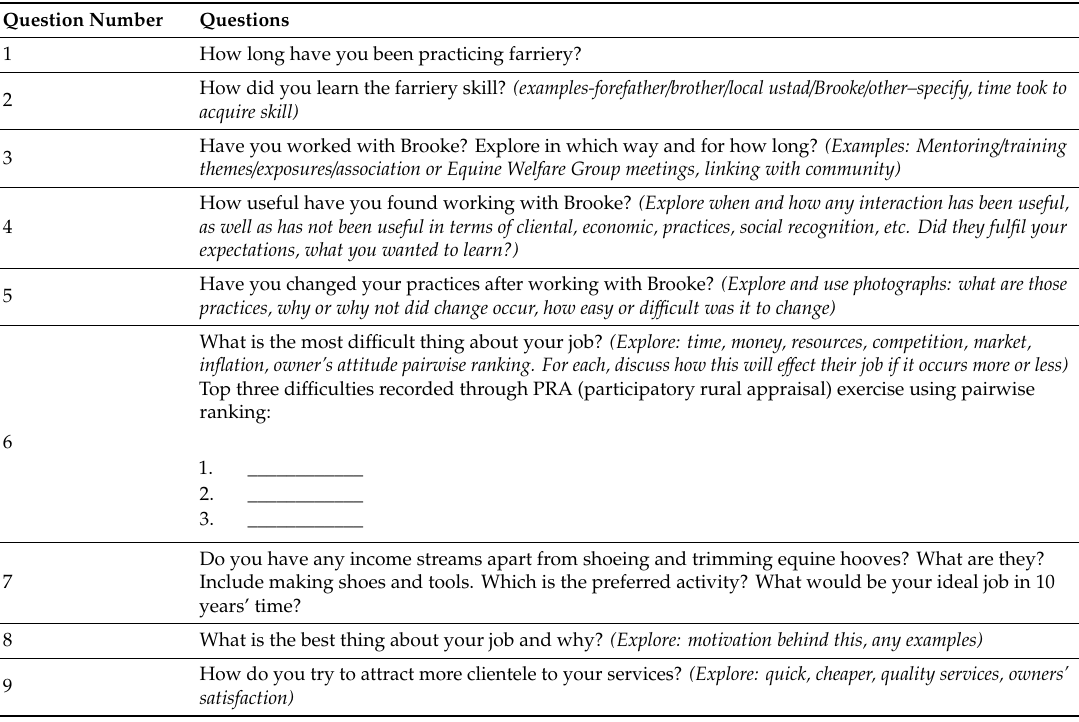
Table 1. Focus group discussion